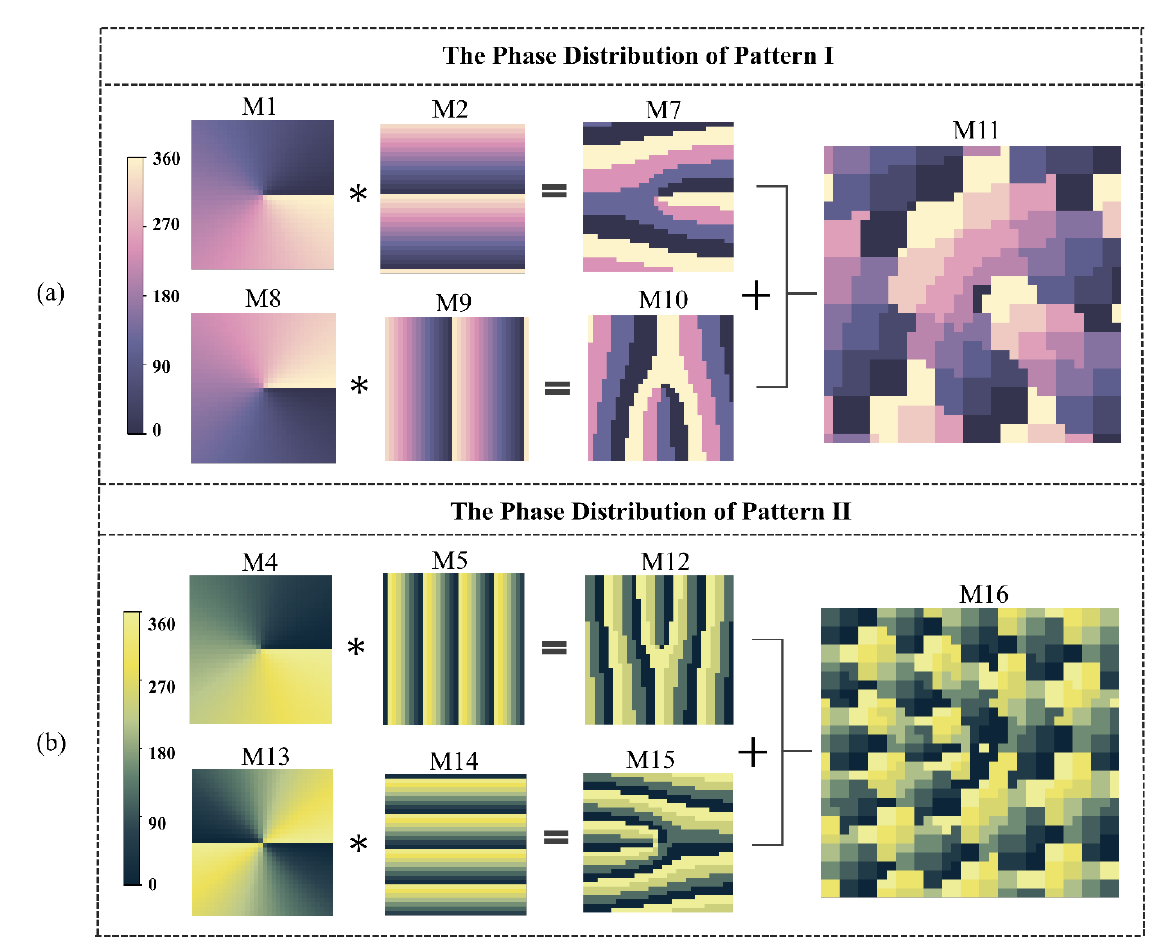
Figure 5. Phase distribution of the multiple beams dual-function OAM generator based on 3-bit coding unit cells. (Here, ‘*’ means the convolution operation.)( a ) Phase distribution of the l 1 = + 1 and l 2 = − 1 deflected vortex beams at 0.6 THz under the y -polarized incidence. ( b ) Phase distribution of the l 3 = + 1 and l 4 = − 2 deflected vortex beams at 0.9 THz under the x -polarized